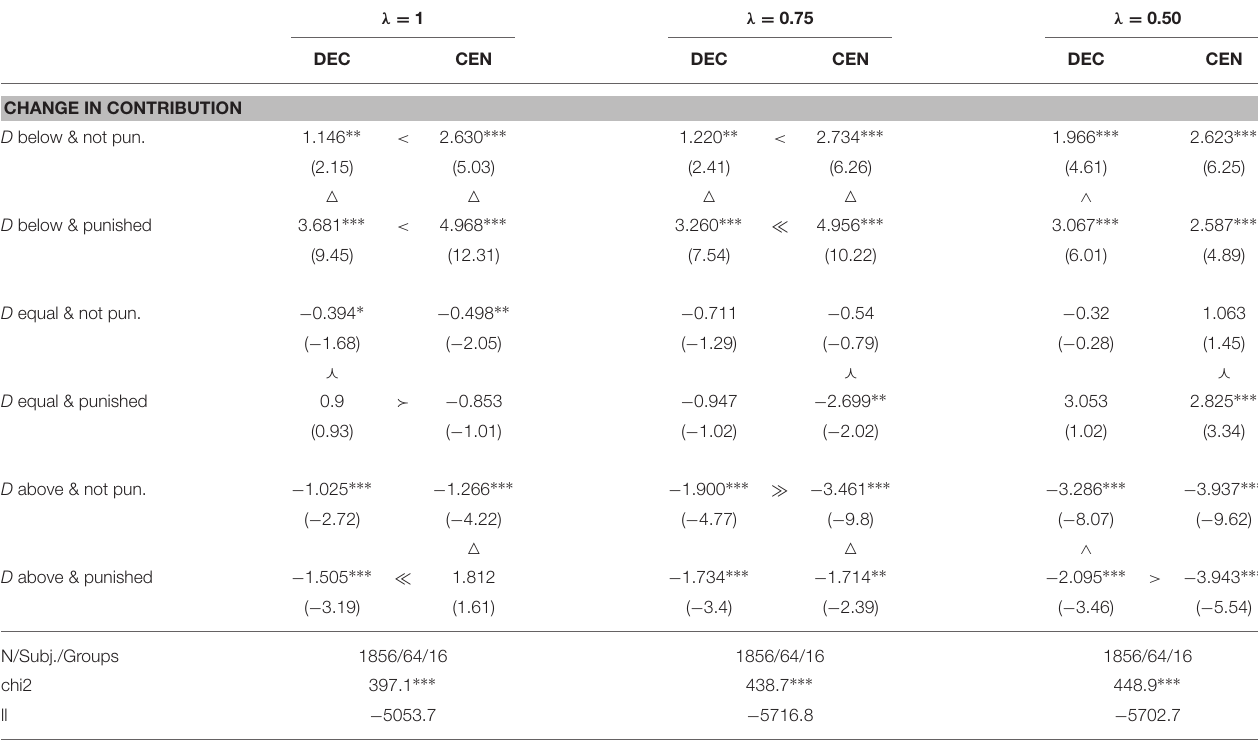
TABLE 5 | Change in